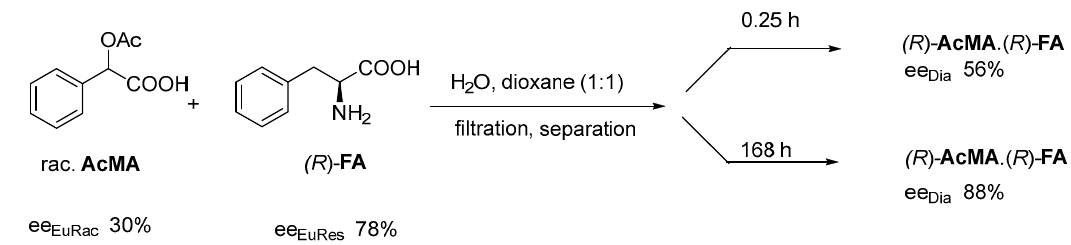
Figure 13. The thermodynamic control is determined by the racemic compound.